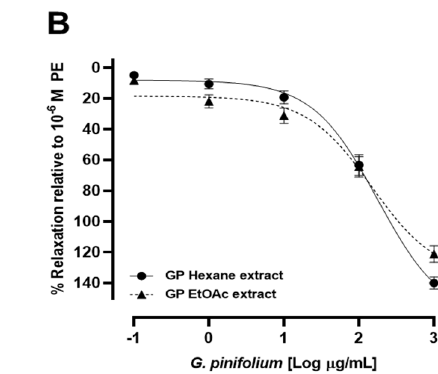
Figure 4. The relaxation effect of G. pinifolium in intact rat aorta. The rat aorta was pre-contracted with 10 − 6 M PE for 10 min, and then, rising concentrations of G. pinifolium Phil. (0.1 to 1000 µ g/mL) were added in the organ bath each 7 min. The original record of the vascular effect of n -hexane extract of G. pinifolium . in intact rat aorta ( A ). Concentration-response curves for G. pinifolium n -hexane and ethyl acetate extract in intact aortic rings ( B ). Data are the average ± SEM of 6 independent experiments. G. pinifolium extracts produce a good relaxation effect at 100 µ g/mL in the